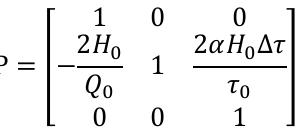
from 0 to 12 and coefficient of discharge 0.3, 0.5 𝒓 and